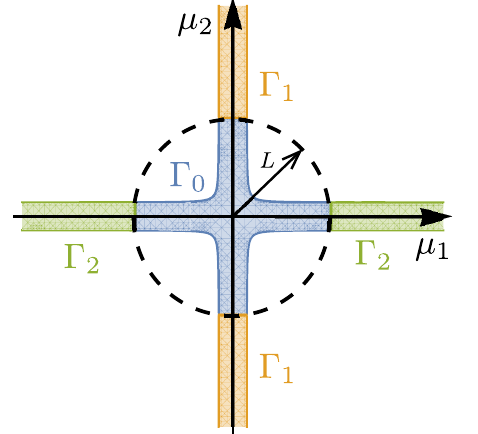
12.FIG. 10. The shaded regions (blue, green, and orange) corre- P 1 = μ 2 > 1 for the case of spond to the domain Γ in which k k D ¼ 4 ( Λ ¼ 2 ) in the f μ 1 ; μ 2 g space. The subdomain Γ 0 , shown in blue, is the part of Γ inside the circle of radius L , and the subdomains Γ are the parts of the domain Γ that lie outside Γ 0 i which do not contain the μ axis ( Γ 1 is shown in orange and Γ 2 in i green). The width of the strips in Γ far away from the origin is 1; hence, the volume of the subdomain Γ 0 will scale as O ð L Λ − 1 Þ for large L